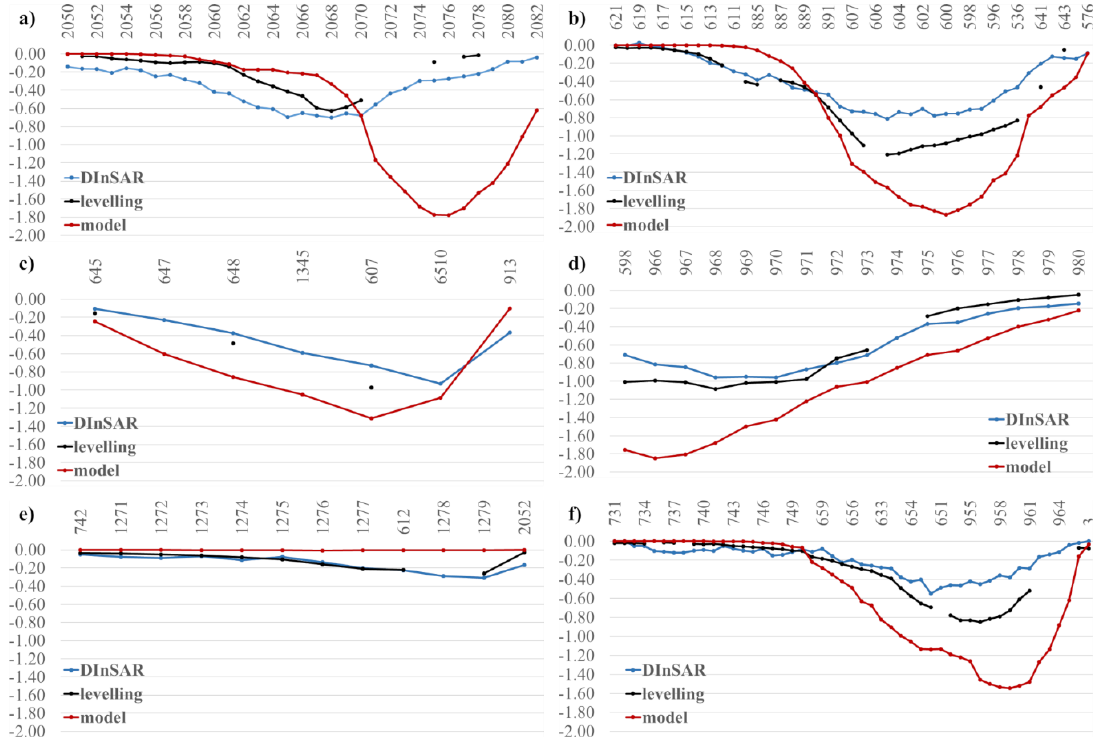
Figure 20. Comparison of the subsidence [in meter] along the levelling lines from Figure 7 between DInSAR results, levelling and predicted by the model data: a) profile along levelling line 1’1”, b) profile along levelling line 2 ’2”, c) profile along levelling line 3’3”, d) profile along levelling line 4 ’4”, e) profile along levelling line 5’5”, f) profile along levelling line 6’6”